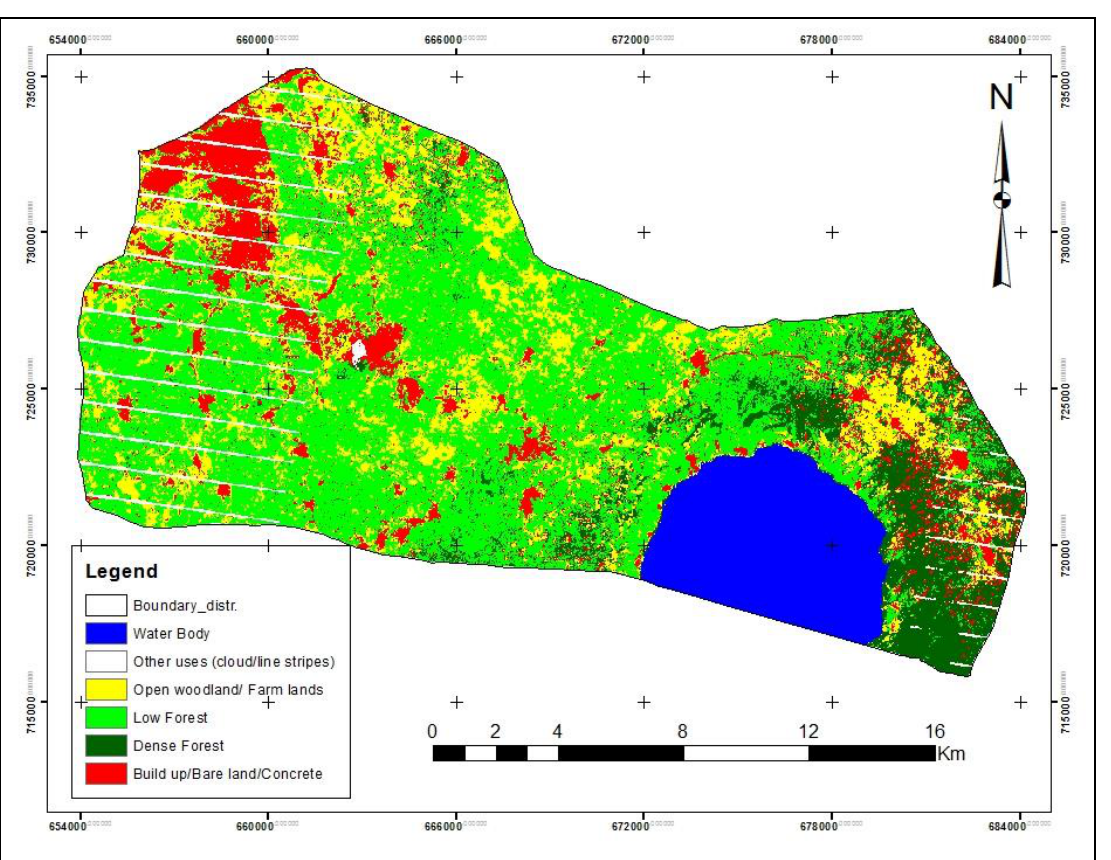
Figure 3. LULC Map of 2010 Landsat ETM+